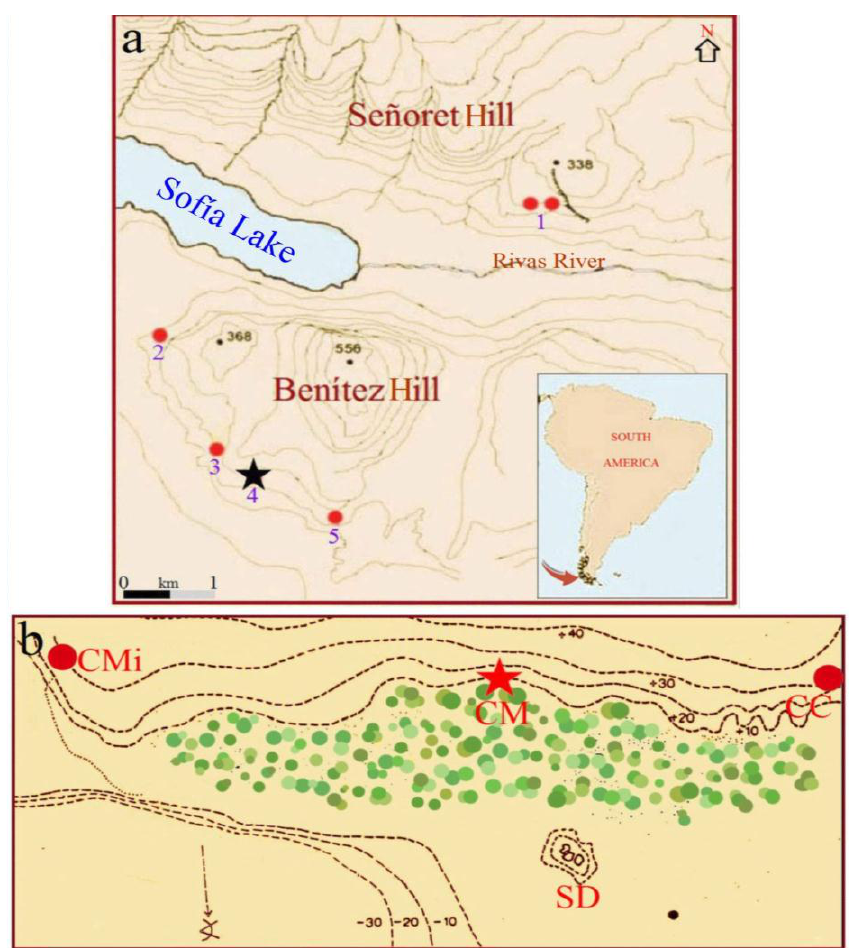
Figure 3. Location maps of the main Late Pleistocene paleontological and archaeological cave sites in the area. ( a ) The Señoret and Benitez hills. 1. Lago Sofía 1 and 2, 2. de la Ventana, 3. Mylodon, 4. del Medio, 5. Chica. The arrow on the map of South America shows the Ultima Esperanza region, ( b ) detail of the SW slope of the Benitez Hill with the locations of the Mylodon (CMi), Medio (CM), and Chica (CC) caves in relation to the “Silla del Diablo” (SD) rock formation in the Mylodon Cave ◦ (cid:48) ◦ (cid:48) National Park. The CM (51 35 S, 71 38 W) is situated ~1 km from the Mylodon cave in the Mylodon